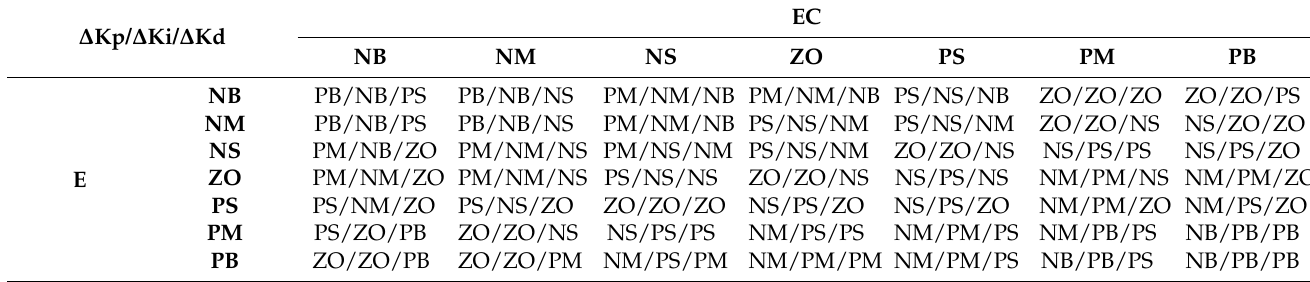
Table 3. The fuzzy rules of ∆ Kp, ∆ Ki, and ∆